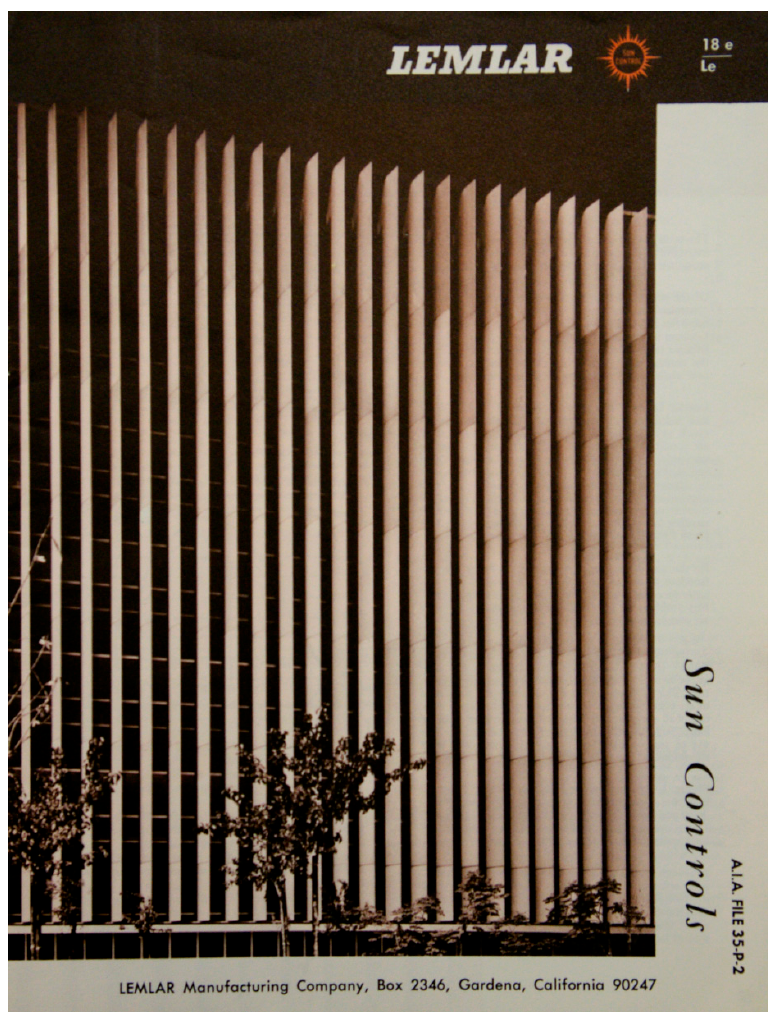
Figure 11. Lemlar Manufacturing Company, cover of a brochure promoting sun control devices, showing Richard Neutra’s Los Angeles County Hall of Records, Los Angeles, 1962.